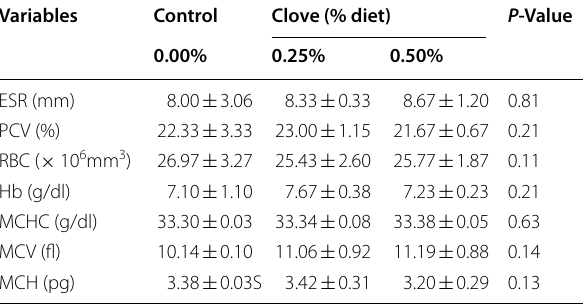
Table 2 Haematology of laying hens fed diets supplemented and Syzygium aromaticum leaf meal Variables Control